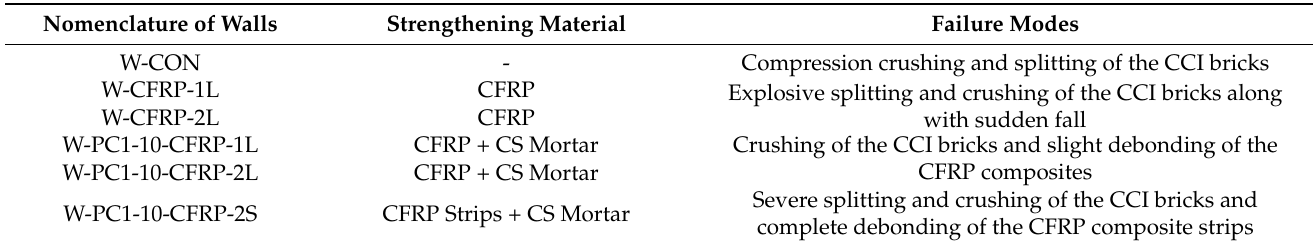
Table 4. Ultimate failure modes of CCI brick masonry